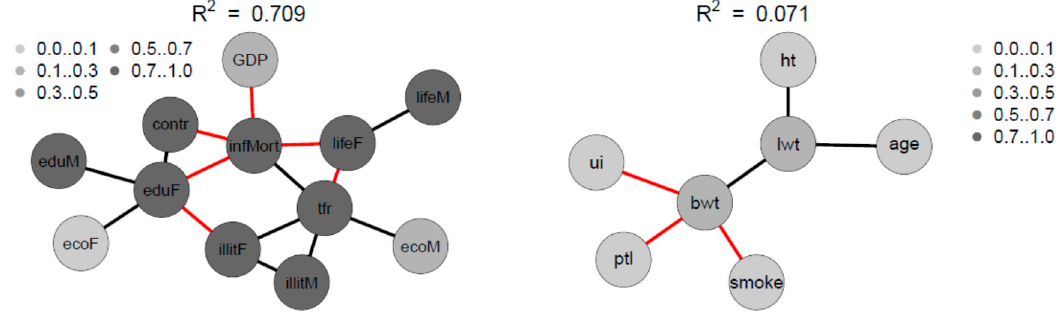
Figure 12. SNHA graph of the correlation matrix of the sample 2 and sample 3. Gray shades depict the amount variance that for each variable is explained by SNHA algorithm. SNHA explains 0.709 of the total variance of sample 2, and 0.071 of the total variance of sample 3.